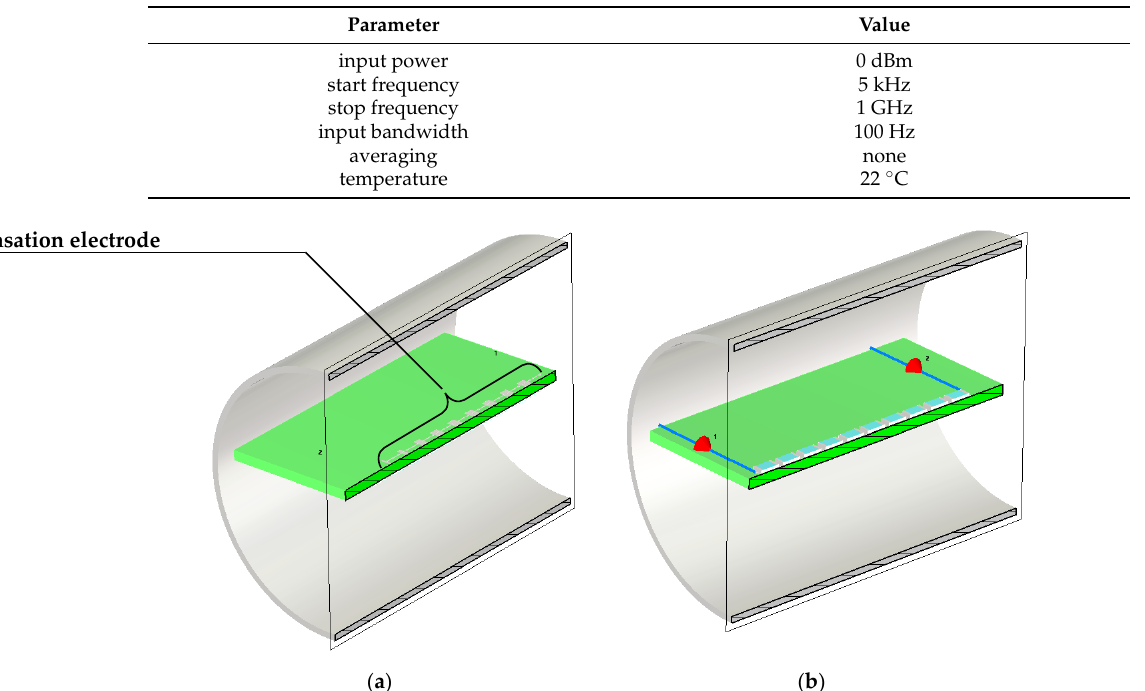
Figure A3. Photo of the built resistive voltage divider in brass housing with high-voltage cable for input signal.